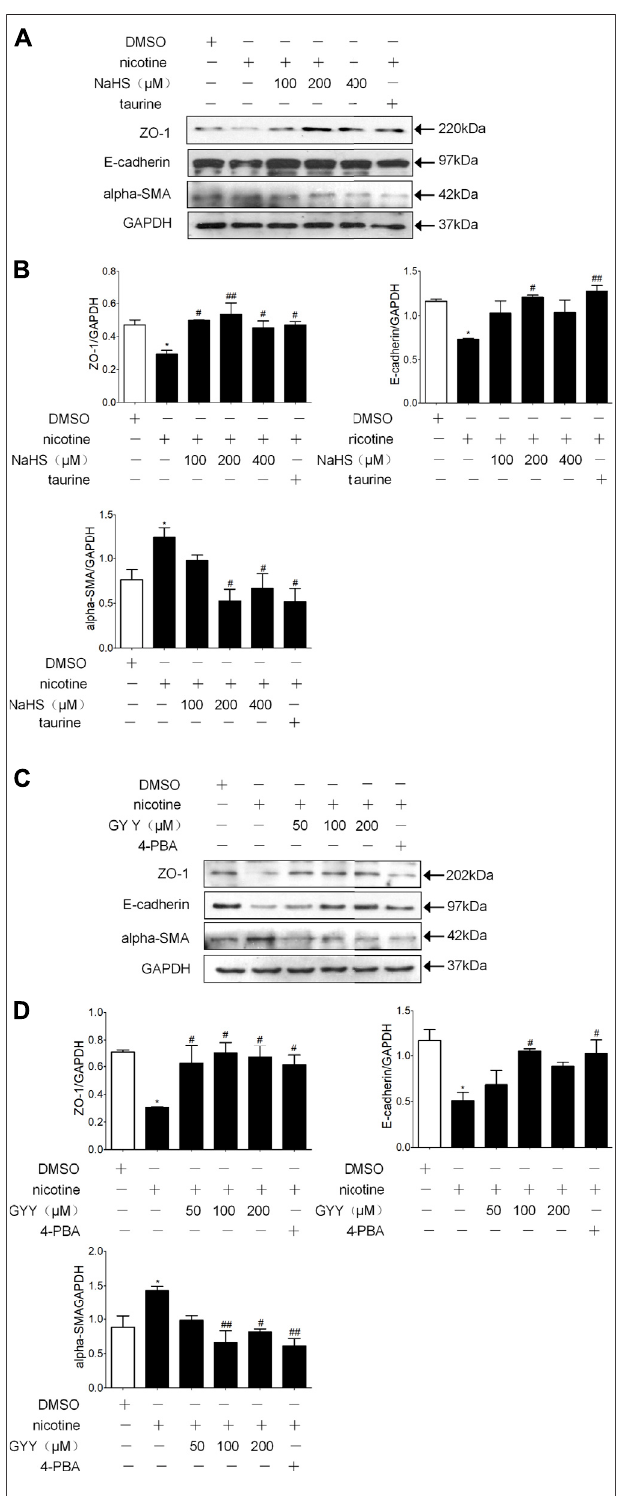
FIGURE5| H 2 SandERstressinhibitorstaurine and4-PBAsuppressed nicotine-induced changesin the expression of EMT markers in 16HBE cells. (A,B) Western blotting analysis of ZO-1, E-cadherin, and alpha-SMA protein expression in 16 HBE cells, and relative intensity normalized to the